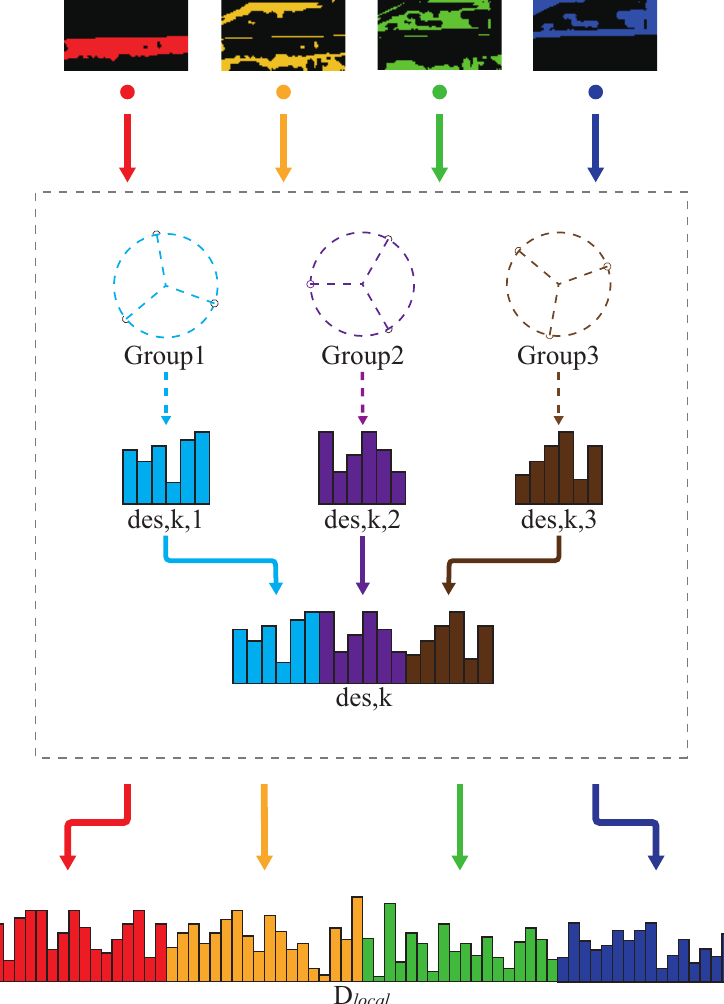
Figure 5. Demonstration of local gradient order descriptor construction